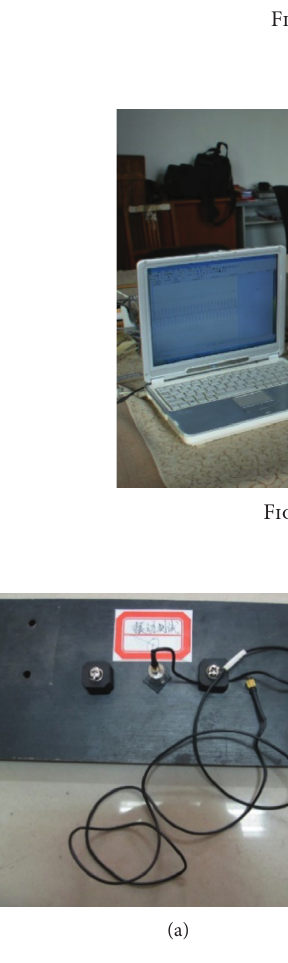
Figure 7: Fixed acceleration sensors. (a) The first test board. (b) The second test